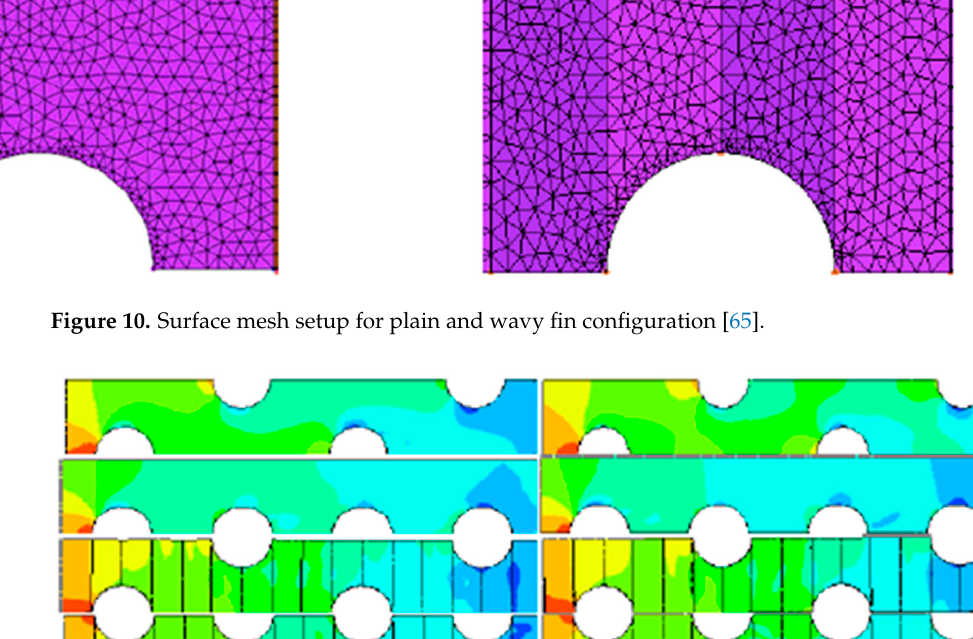
Energies 2023 , 16 , x FOR PEER REVIEW Figure 11. Pressure distribution for the fin configuration [65]. Figure 11. Pressure distribution for the fin configuration [65]. Figure 11. Pressure distribution for the fin configuration [65].